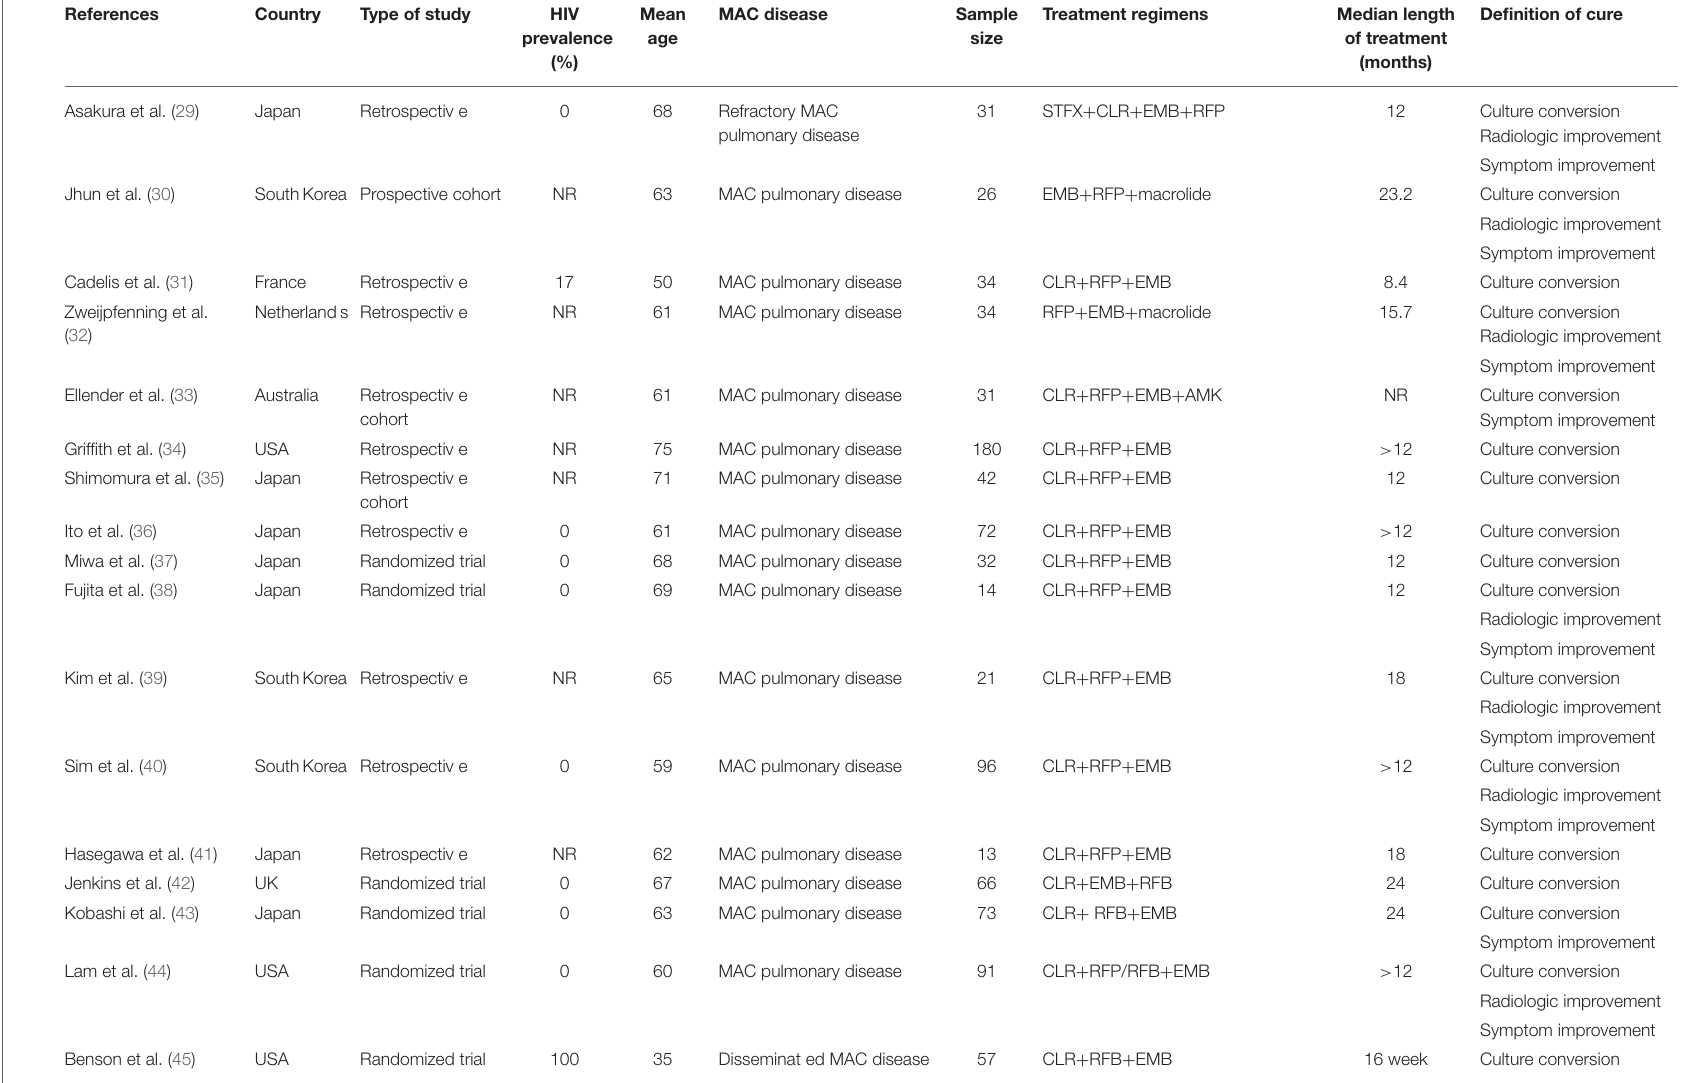
TABLE 2 | Characteristics of studies without clofazimine in their